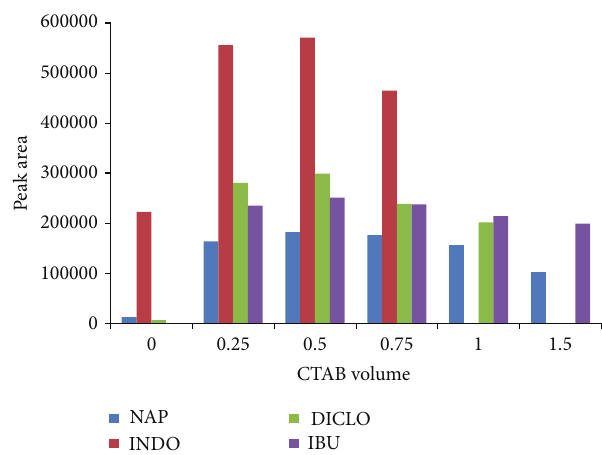
Figure 3: The adsorption performance of nonsteroidal anti- inflammatory drugs as a function of the amount of CTAB